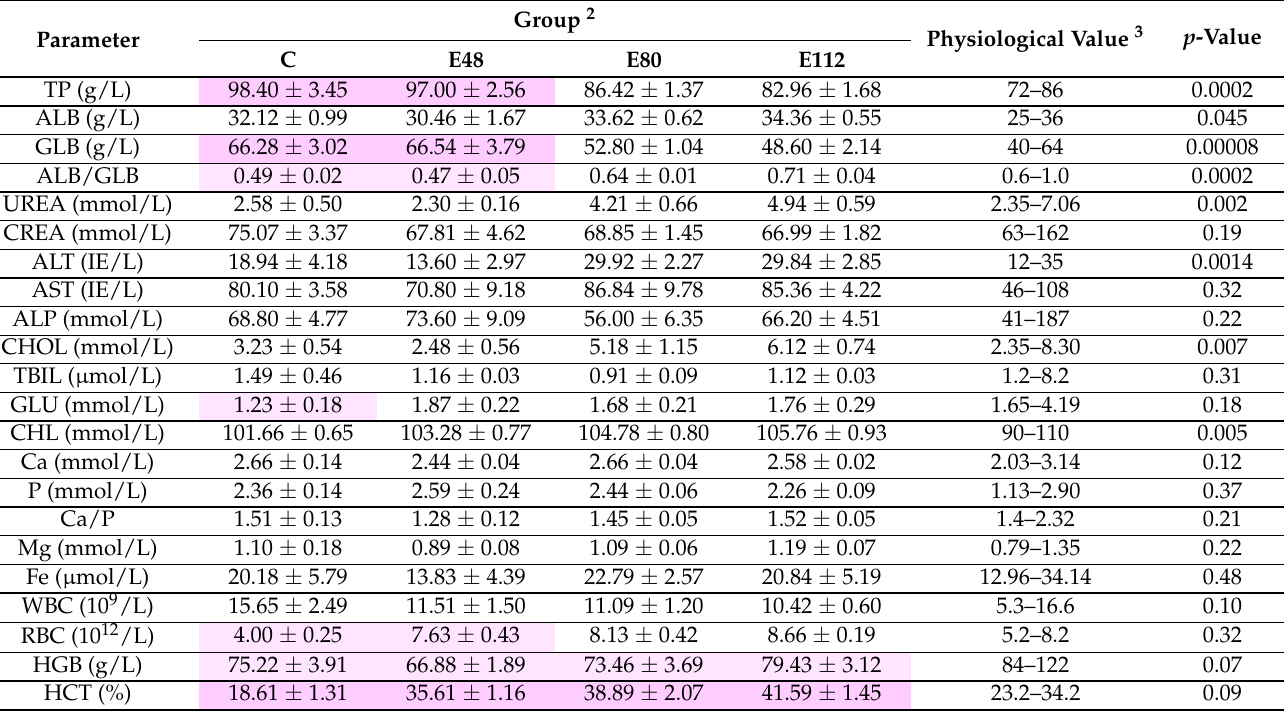
Table 6. Biochemical and morphological parameters of the blood at the end of the experiment (d98) 1 .